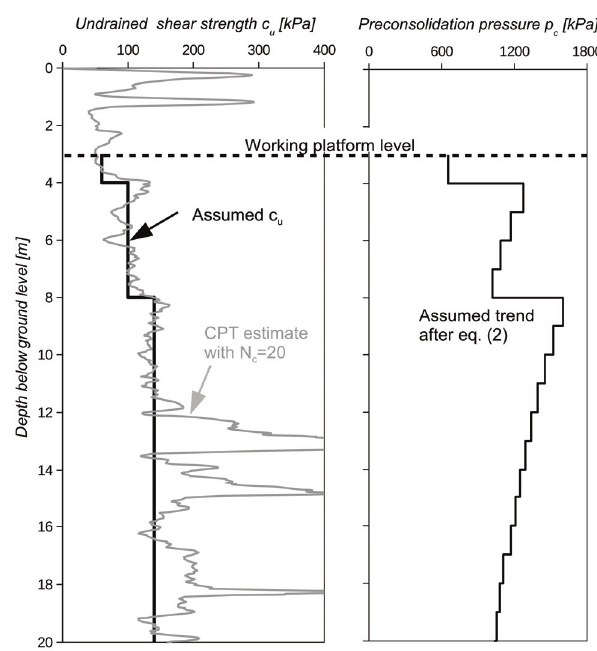
Fig. 4. Undrained shear strength and corresponding preconsolidation pressure distributions